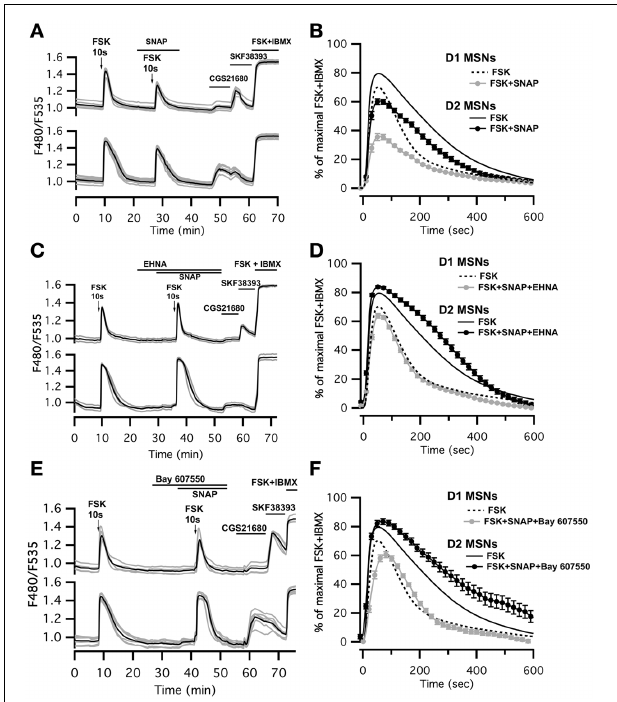
FIGURE 4 | SNAP reduces the cAMP/PKA signal in both D 1 and D 2 MSNs. cAMP signals were measure in wide-field imaging with Epac-S H150 biosensor during the application of a 10s pulse of Forskolin (FSK, 13 µ M). (A) Activation of soluble guanylyl cyclase with SNAP (100 µ M) strongly reduced the amplitude of the cAMP response induced by brief (10s) FSK application in both D 1 and D 2 MSNs. Inhibition of PDE2 with EHNA (10 µ M) (C) or Bay 607,550 (100nM) (E) abolished the effect of SNAP on the cAMP response. (B) Mean responses in D 1 ( n = 45) and D 2 ( n = 48) MSNs to brief FSK stimulation in the presence of SNAP. (D) Mean responses in D 1 ( n = 46) and D 2 ( n = 44) MSNs to brief FSK stimulation in the presence of SNAP plus EHNA; (F) Mean responses in D 1 ( n = 38) and D 2 ( n = 25) MSNs to brief FSK stimulation in the presence of SNAP plus Bay 607,550. (B,D,F) dashed and solid lines represent the average response to brief FSK alone in D 1 and D 2 MSNs, respectively. Markers are plotted sparsely for clarity; error bars represent SD .